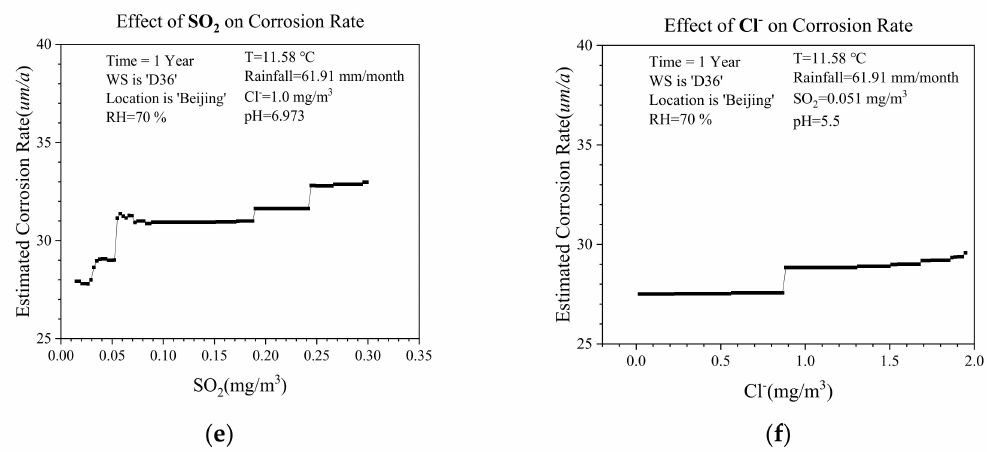
Figure 10. Corrosion rate prediction when changing one of the environmental factors. ( a ) pH, ( b ) RH, ( c ) Rainfall, ( d ) Temperature, ( e ) SO 2 , ( f ) Cl −